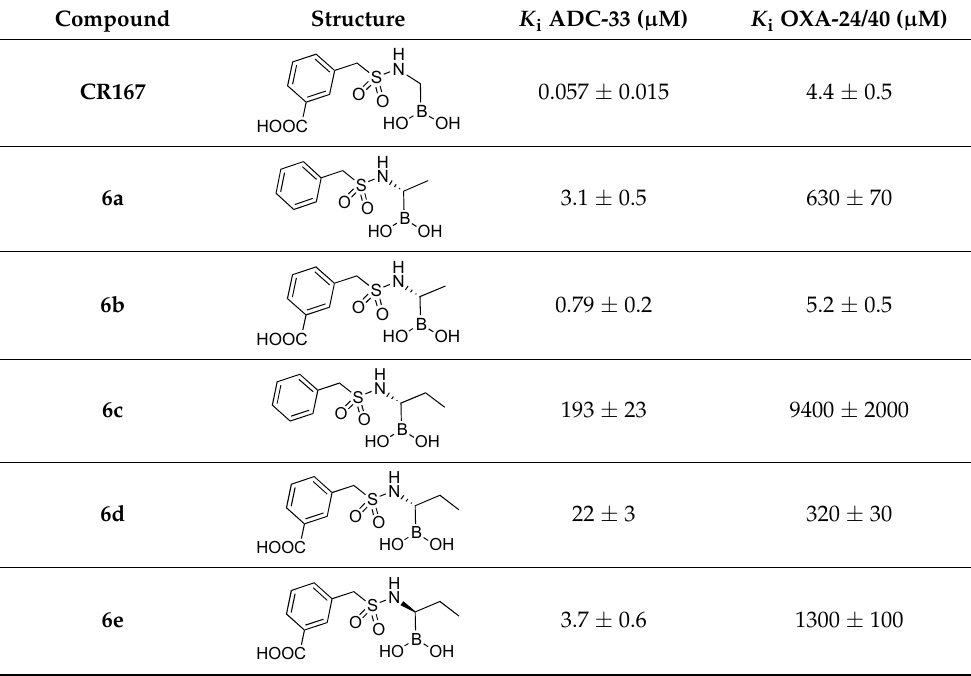
Table 1. K i values of compounds CR167 and 6a – e . All values are corrected for nitrocefin (NCF) affinity. Compound